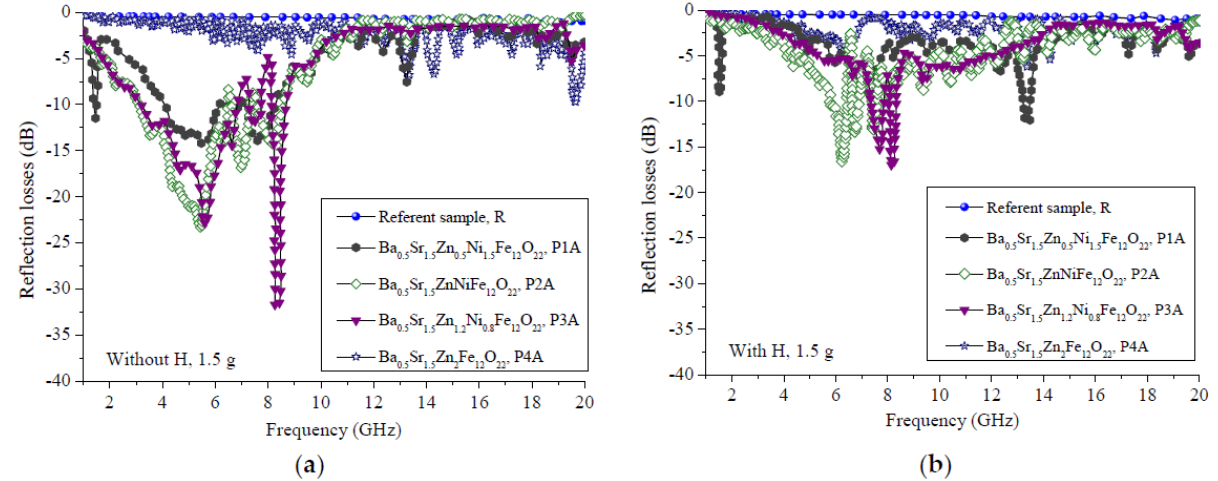
Figure 4. Reflection losses of the A series of samples with a filler ratio of 1.5 g per 1 cm 3 ( a ) with a magnetic field and ( b ) without an external magnetic field applied.